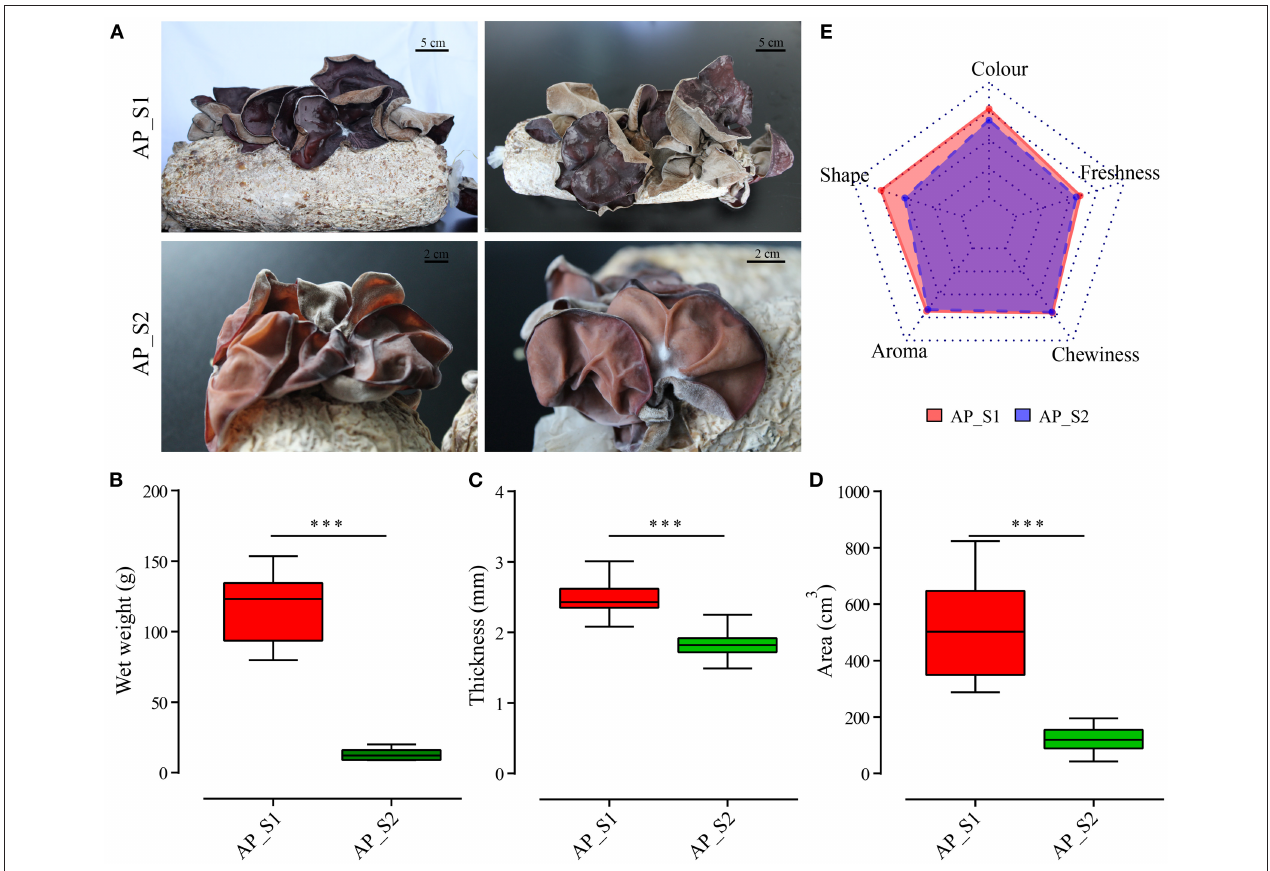
FIGURE 1 | Biological characteristics and nutritional analysis between the two different harvesting periods of Auricularia polytricha (A. polytricha) . (A) Phenotype of the fruiting body of “AP_S1” (a, b) and “AP_S2” (c, d). The biomass (B) , area (C) , and auricle thickness (D) of “AP_S1” (red) and “AP_S2” (green), respectively. (E) The sensory evaluations of “AP_S1” and “AP_S2”. *** P <